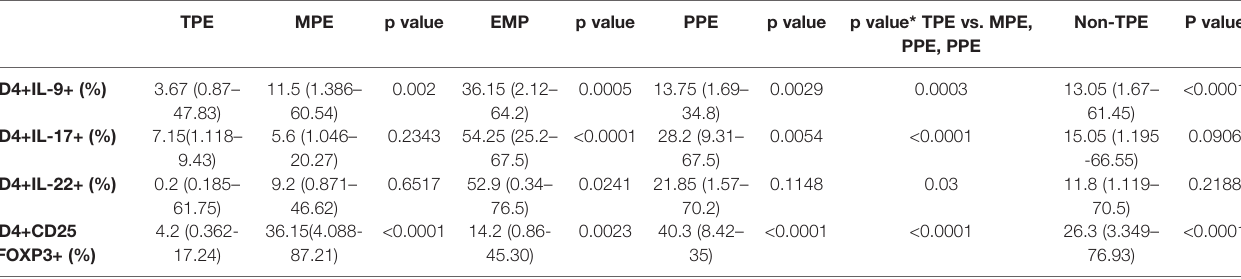
TABLE 3 | The frequency of CD4+IL-9+, CD4+IL-17+, CD4+ IL-22+, and CD4+CD25+FOXP3+ cells in the pleural